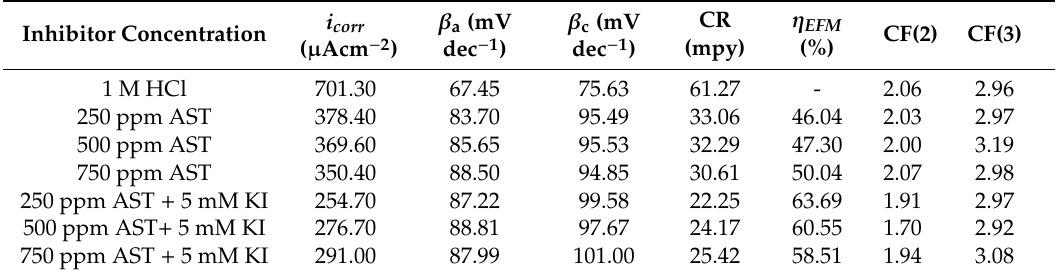
Table 3. Electrochemical kinetic parameters obtained from EFM for C1018 carbon steel in 1 M HCl at various concentrations of AST and AST + KI at 25 ◦